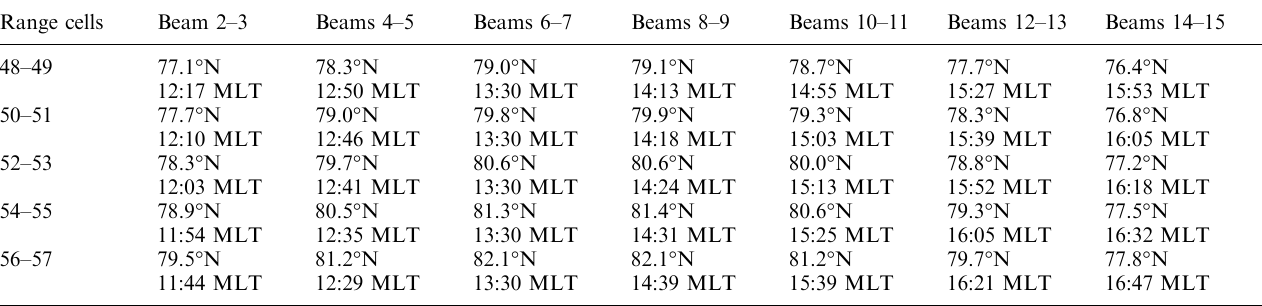
Table 1. AACGM latitude and local time of the centres of 4-cell clusters of measurement points within the CUTLASS-Finland radar field of view relevant to this study. The clusters correspond to Range